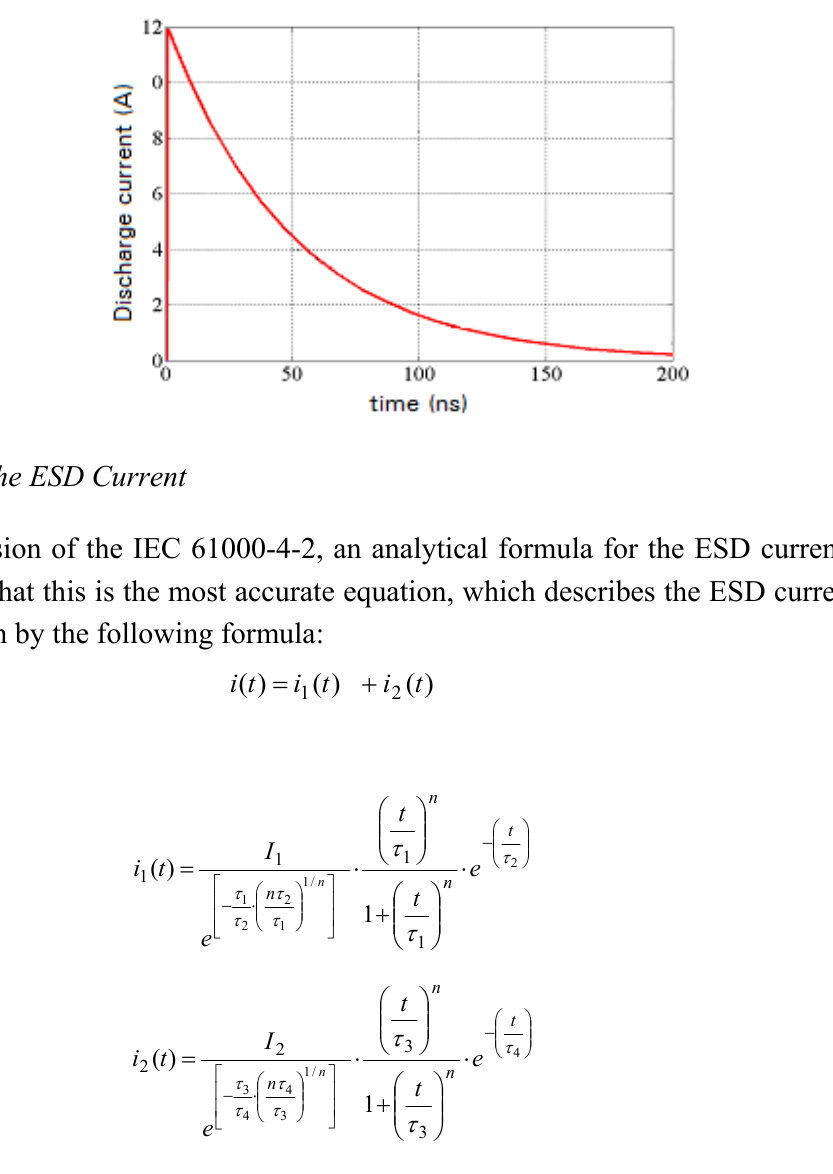
Figure 3. Current waveform of the circuit of Figure 2 using